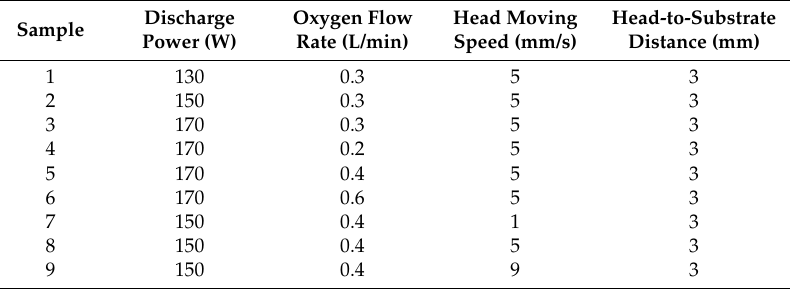
Table 1. Combination of plasma operational parameters.